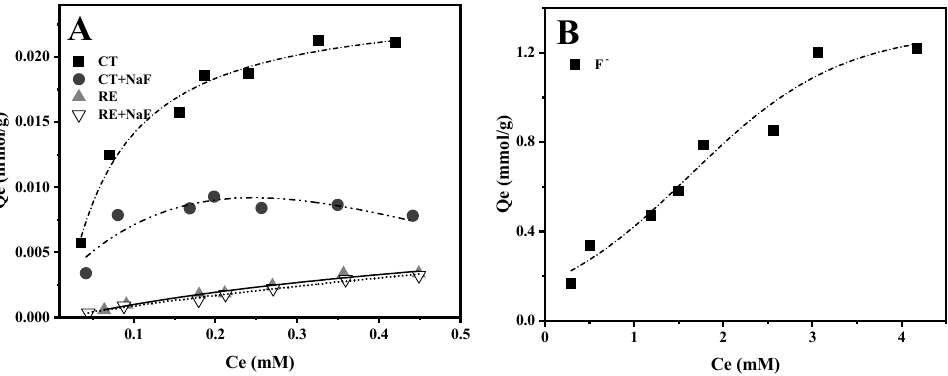
Figure 4. Adsorption curve of catechol (CT) and resorcinol (RE) on TiO 2 in the presence or absence of NaF, pH 4.5, [NaF] = 5 mM ( A ); Adsorption curve of F − on TiO 2 , pH 4.5, [NaF] = 5 mM ( B ).